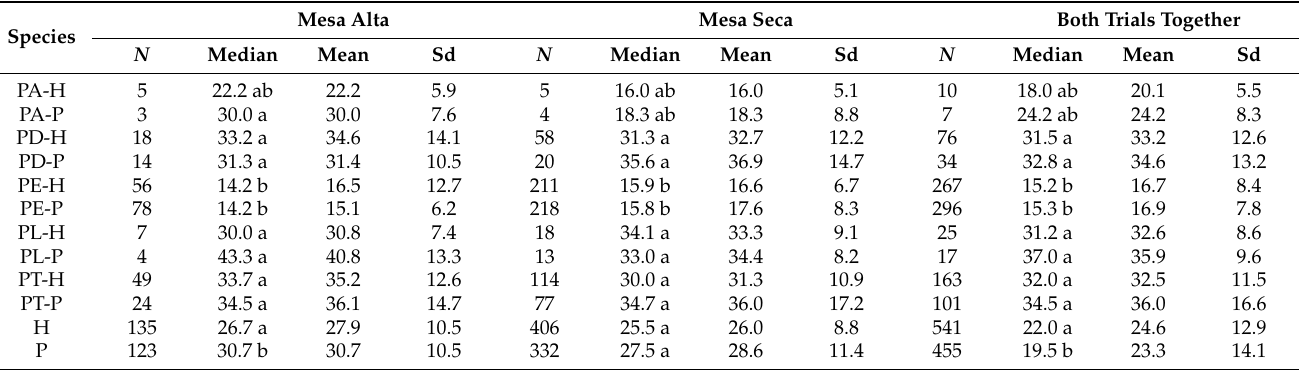
Table 3. Descriptive statistics of height to the apical bud (cm) of Pinus seedlings per species and their hybrids, in each trial and both trials together, after growing for 27 months in the field.